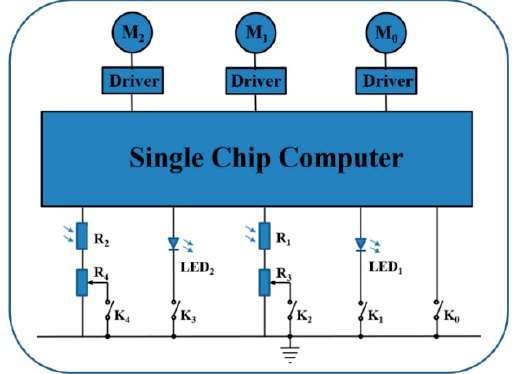
Figure 15. The working principle of the automatic scanning robot arm.